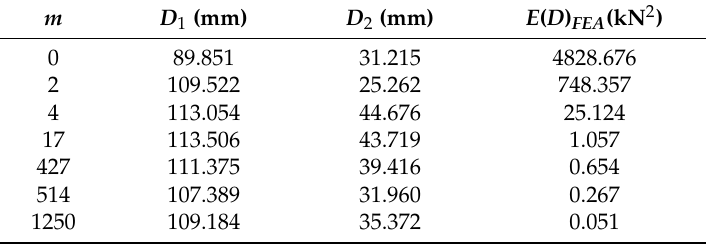
Table 3. Better function values accepted by the local search algorithm.